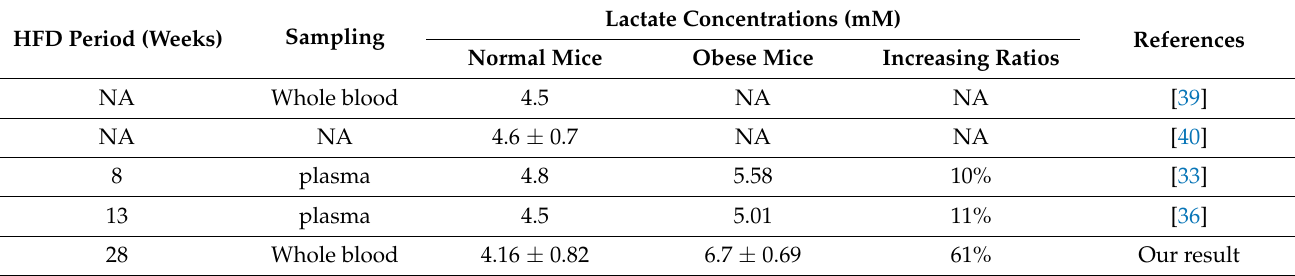
Table 4. Comparison of lactate concentrations in blood samples of mice with previously reported concentrations. HFD Period